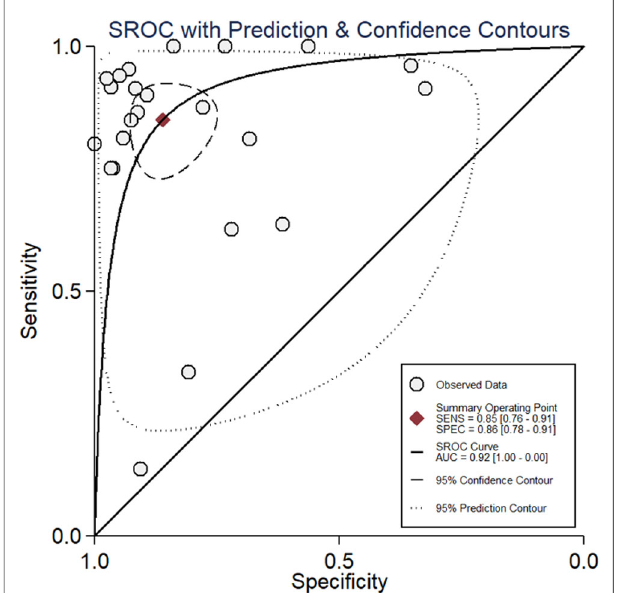
FIGURE 4 | SROC Curve for PET/CT for diagnosing PJI.